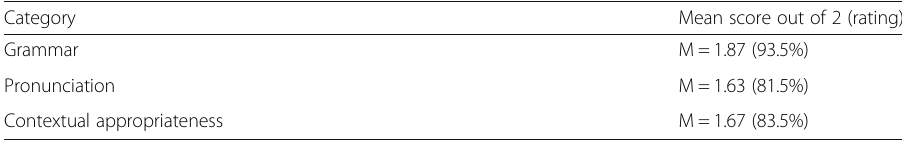
Table 4 The ratings of the Language Use